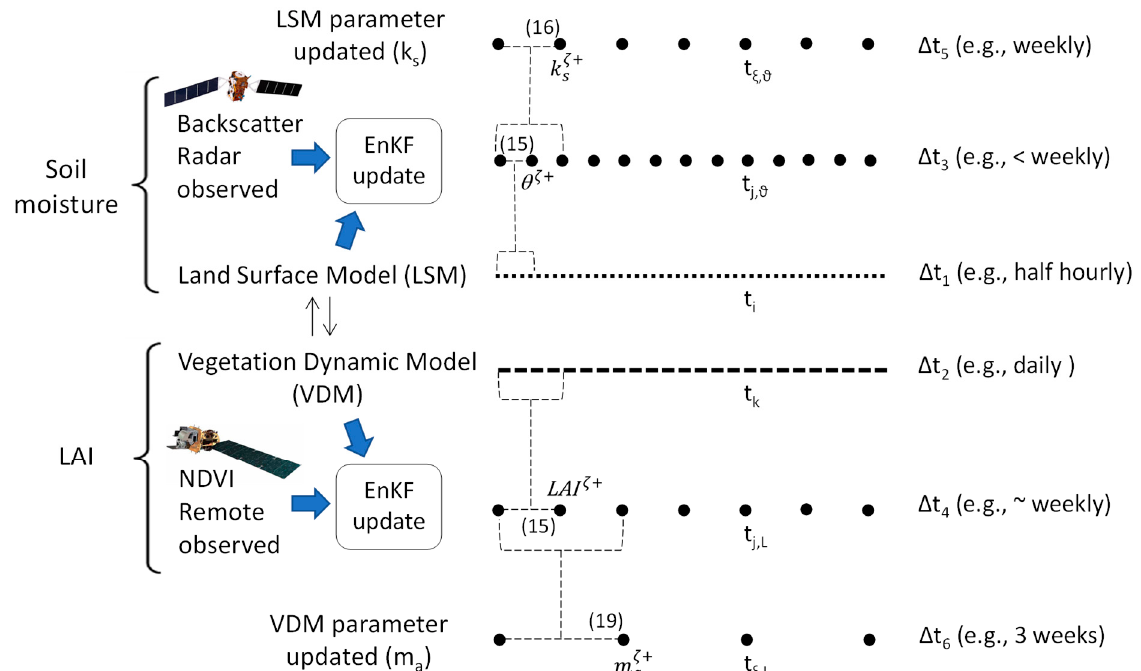
Figure 2. The scheme of the multiscale assimilation approach: soil moisture ( θ ) and leaf area index (LAI) are the two assimilated and predicted variables by the coupled land surface model (LSM) and vegetation dynamic model (VDM); the saturated hydraulic conductivity (k s ) and the maintenance respiration coefficient (m a ) are the dynamically updated parameters through the assimilation approach; EnKF is the ensemble Kalman filter applied to both LSM and VDM. The timescales of the models, ENKF, and parameter updating are reported. The equations for the θ , LAI, k s , and m a adjustments are referenced within